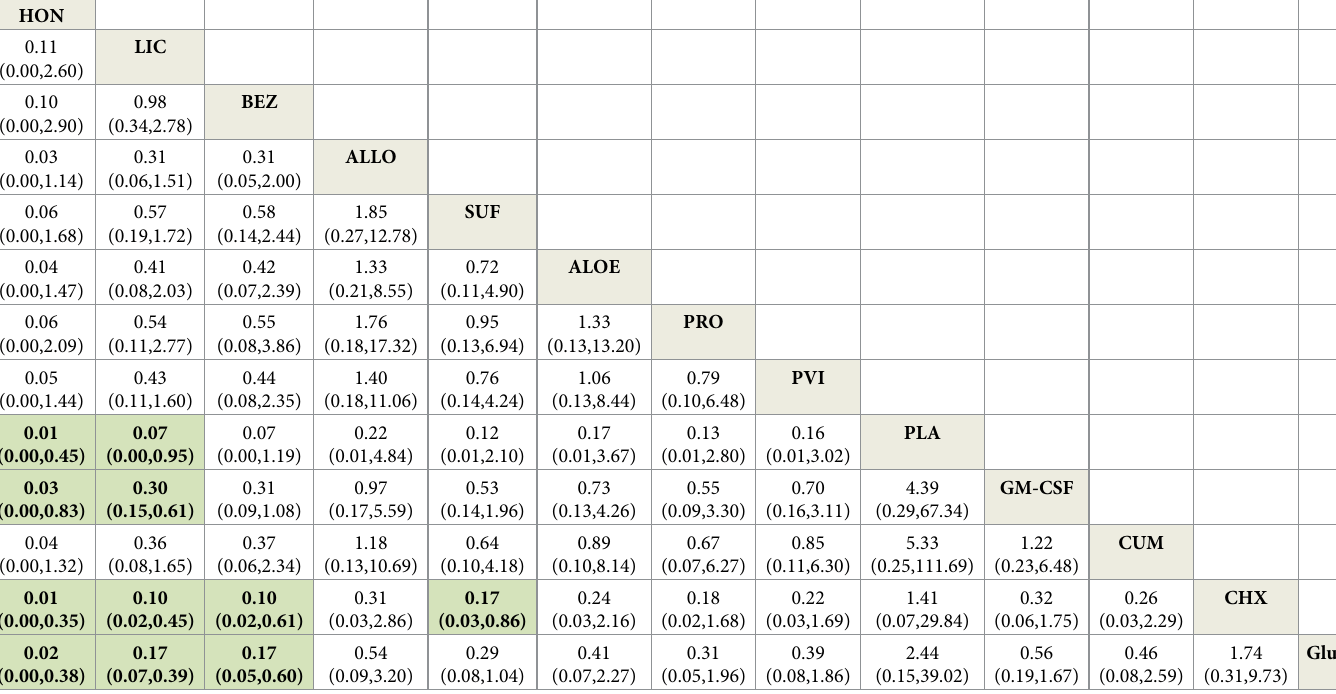
Table 3. Results of the incidence of moderate-severe oral mucositis; results presented as constant odds ratios between all competing interventions with 95% confi- dence intervals. � Comparisons of treatments should be read from left to right. The rate ratio lower than 1 favors the top left treatment. The treatments have been sorted from left to right according to treatment ranking. Statistically significant differences between regimens are shown in bold with green